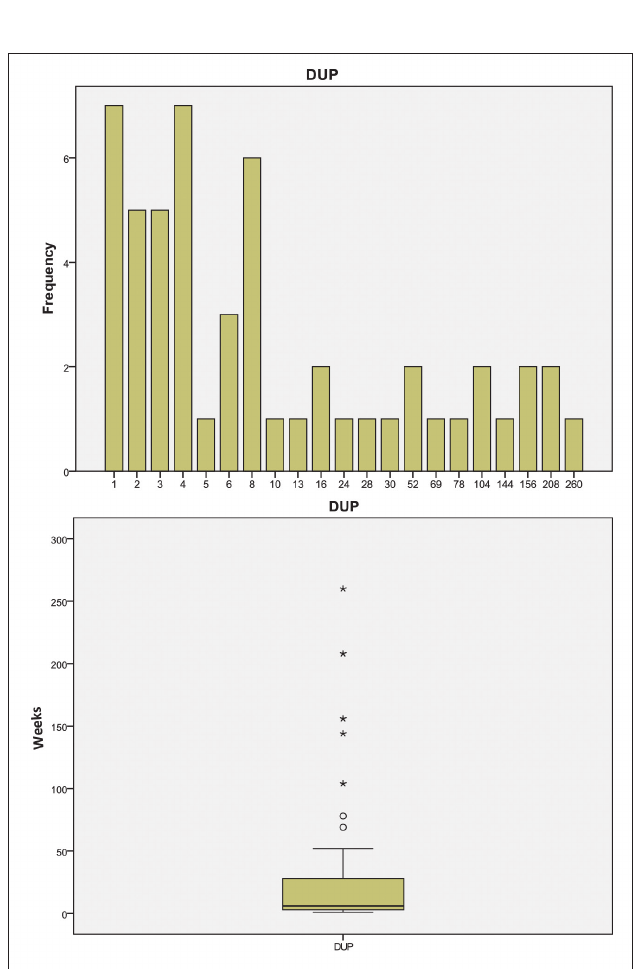
Fig. 1. Skewed distribution of